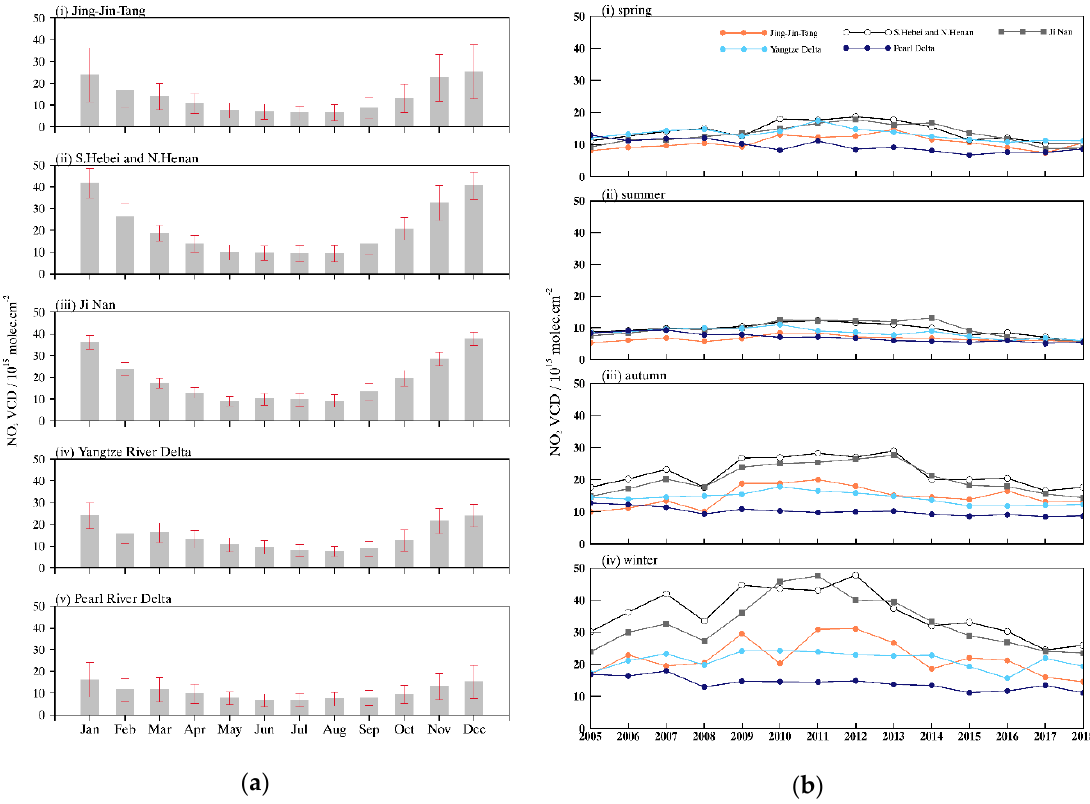
Figure 8. ( a ) Monthly NO 2 column averages in five hotspots during 2005–2018 (unit: 10 15 molec cm − 2 ), with error bars representing the standard error; and ( b ) variations in the seasonally averaged columns in five hotspots during 2005–2018 (unit: 10 15 molec cm − 2 ).